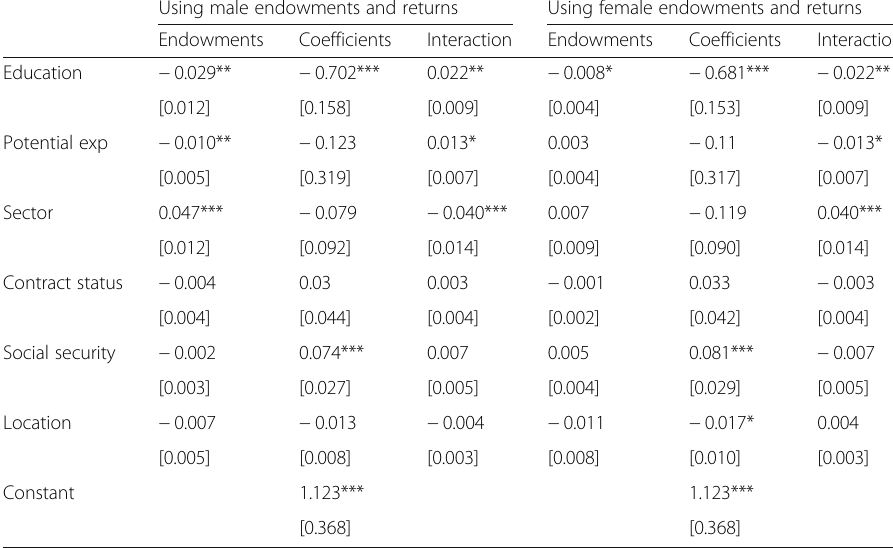
Table 19 Detailed threefold income decompositions: Ukraine Using male endowments and returns Using female endowments and returns